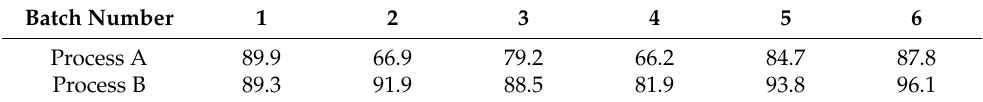
Table 5. Comparison of the final purities in fibres (%) for the two processes tested (i.e., A and B). Batch